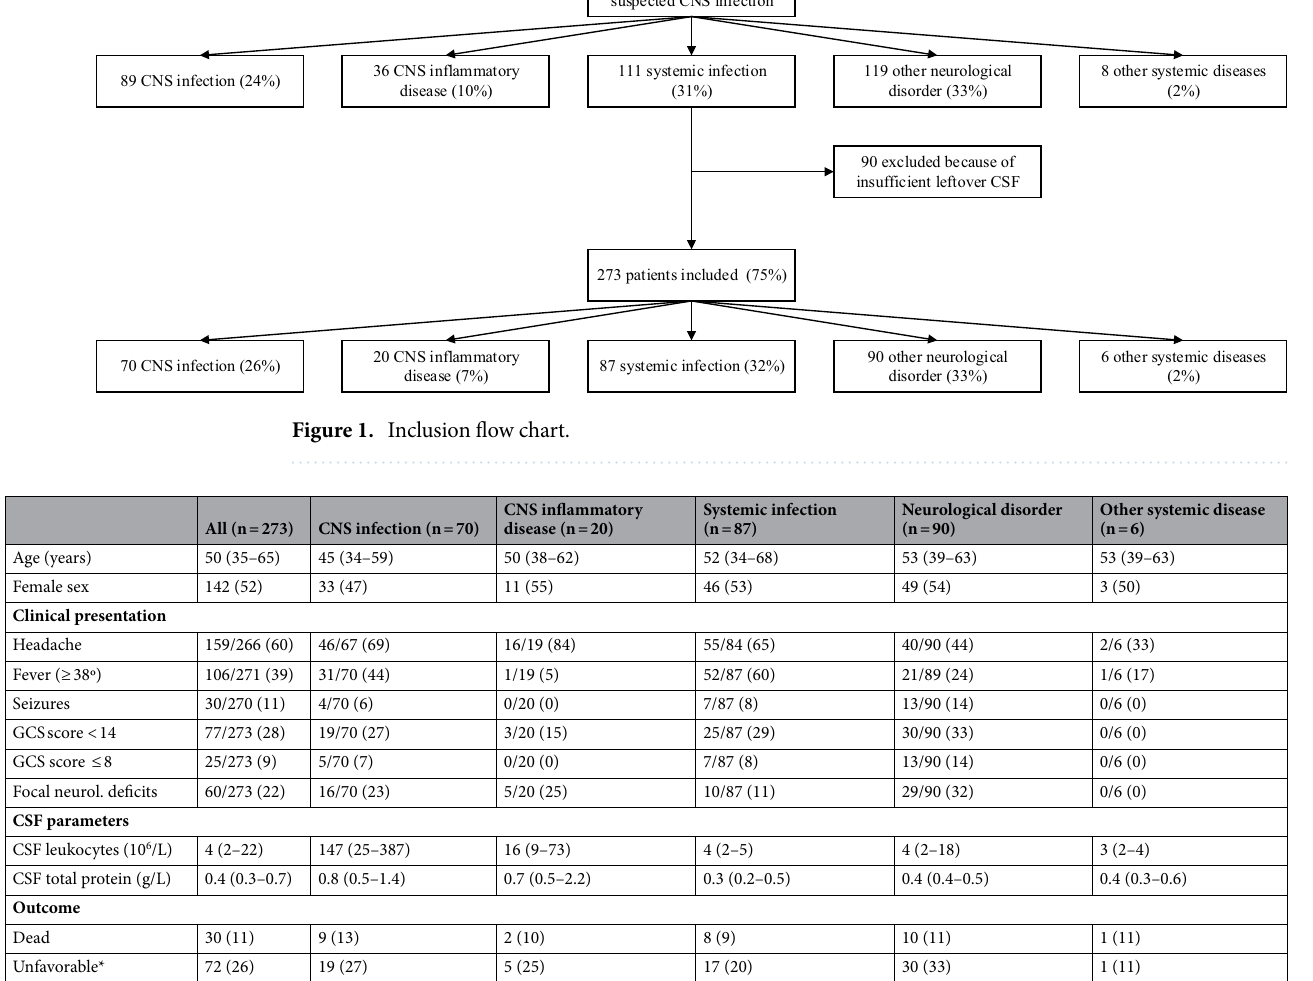
Table 1. Baseline characteristics. Values are medians (interquartile range) or n/N (%). CNS central nervous system, GCS Glasgow Coma Scale, CSF cerebrospinal fluid. *Unfavorable outcome is defined as a Glasgow Outcome Scale score of <